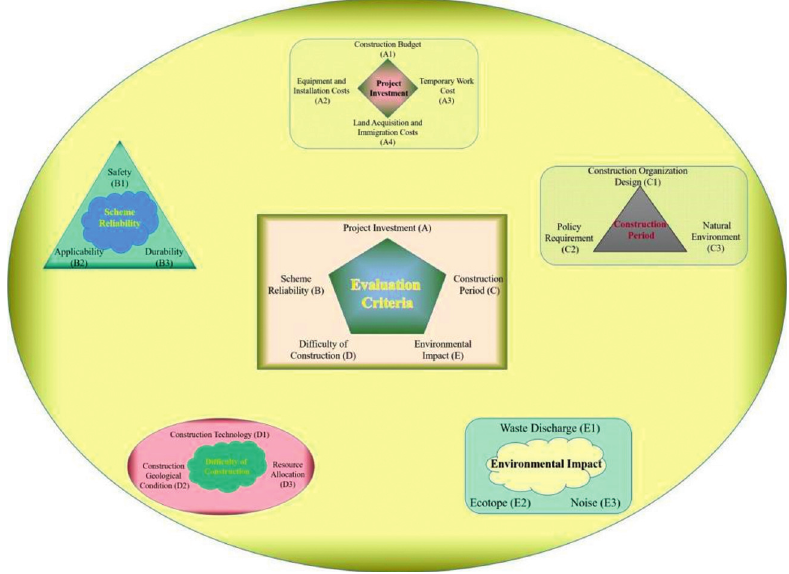
Figure 1: Scheme selection of the analytic network process (ANP) structure.